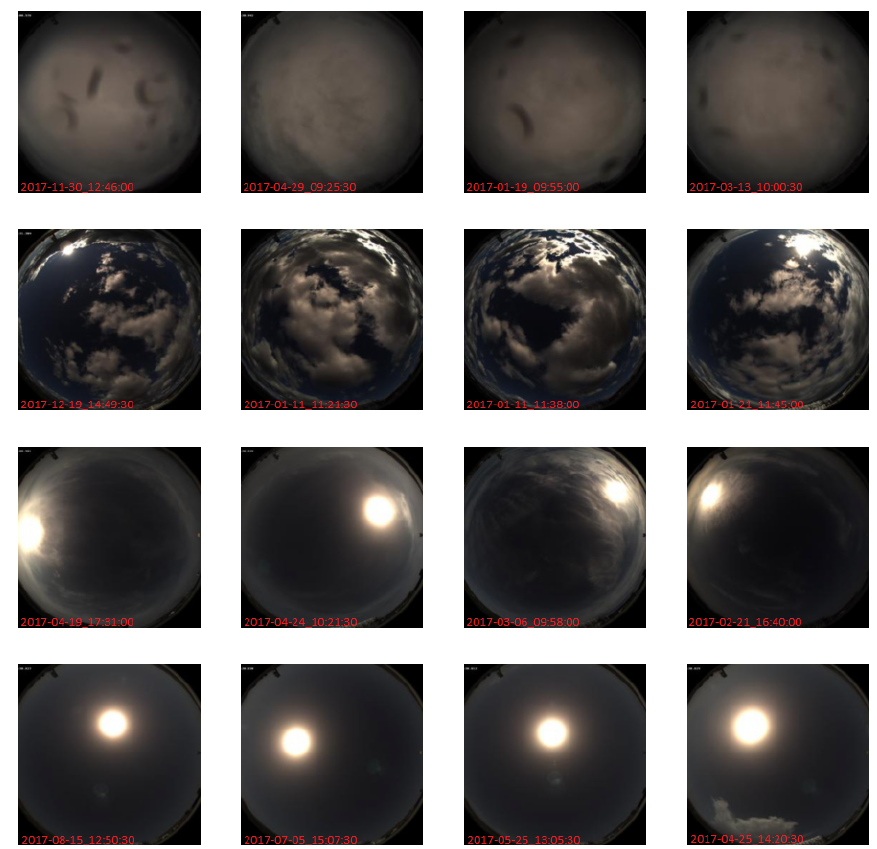
Figure 5. Four randomly chosen samples of four clusters after training. The images of each row correspond to one